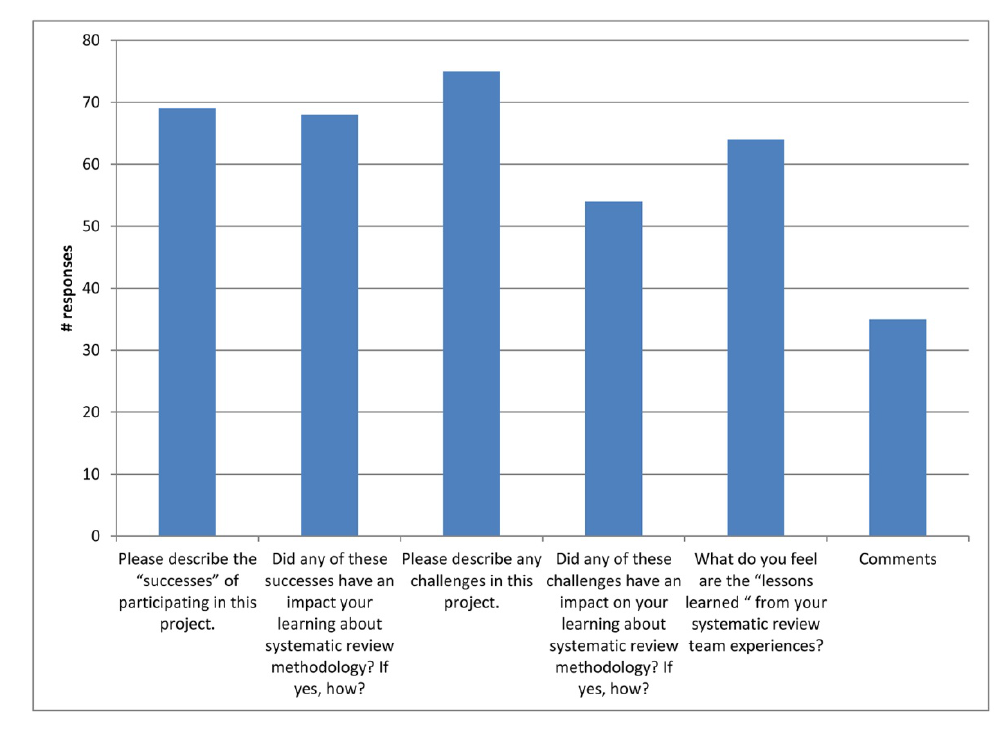
Figure 1 The number of respondents providing answers to the survey questions evaluated in the thematic